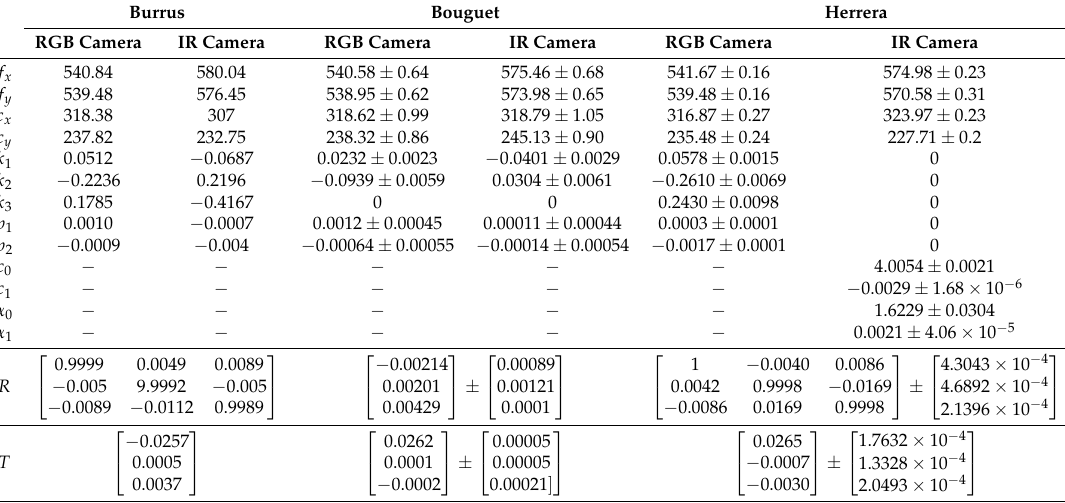
Table 4. Calibration results for Primesense Carmine